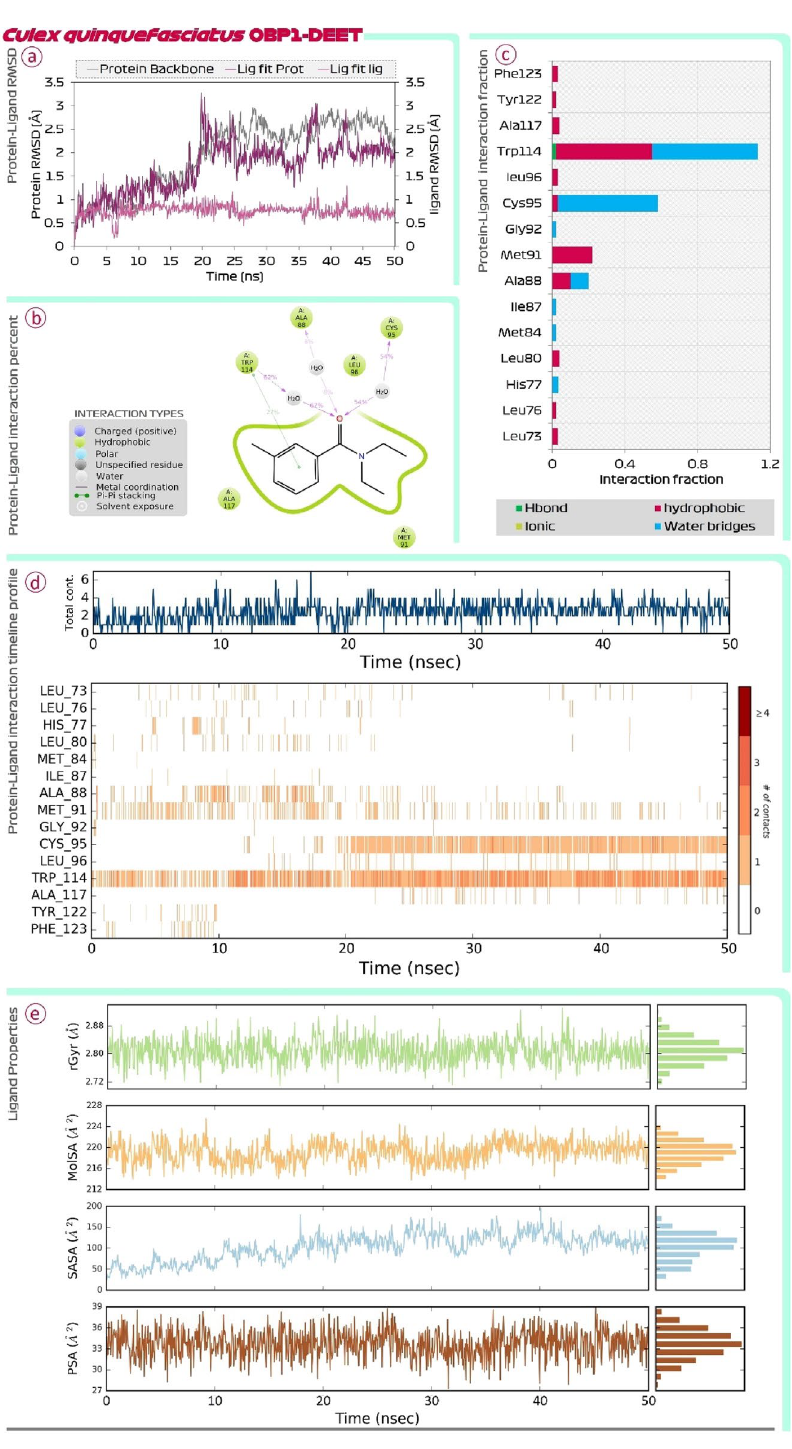
Figure 4. MD simulation assessment of DEET-OBP1 (3OGN) complex of C. quinquefasciatus , ( a ) RMSD profile, ( b ) percent interaction, ( c ) interaction fraction profile, ( d ) interaction timeline profile and, ( e ) Ligand properties during simulation